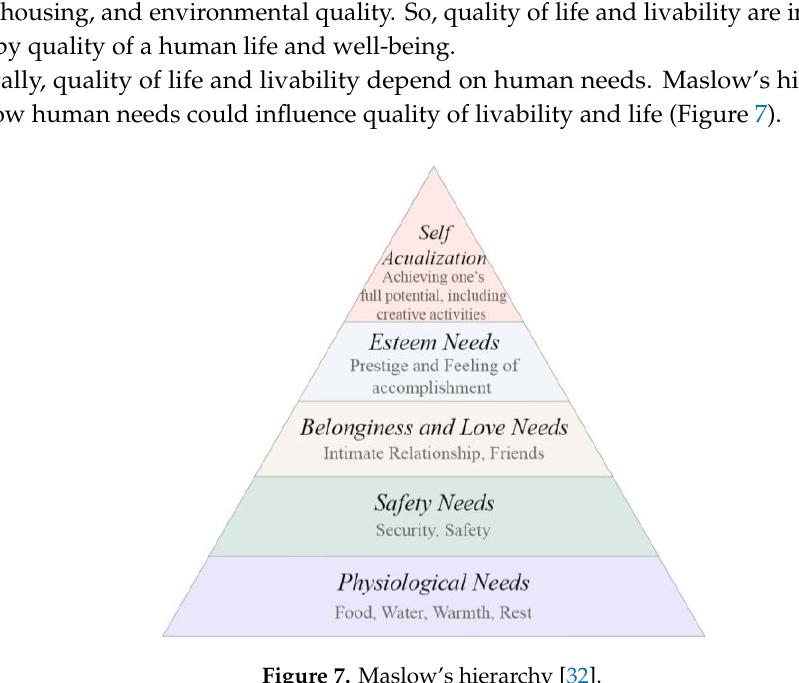
Figure 7. Maslow’s hierarchy [32].